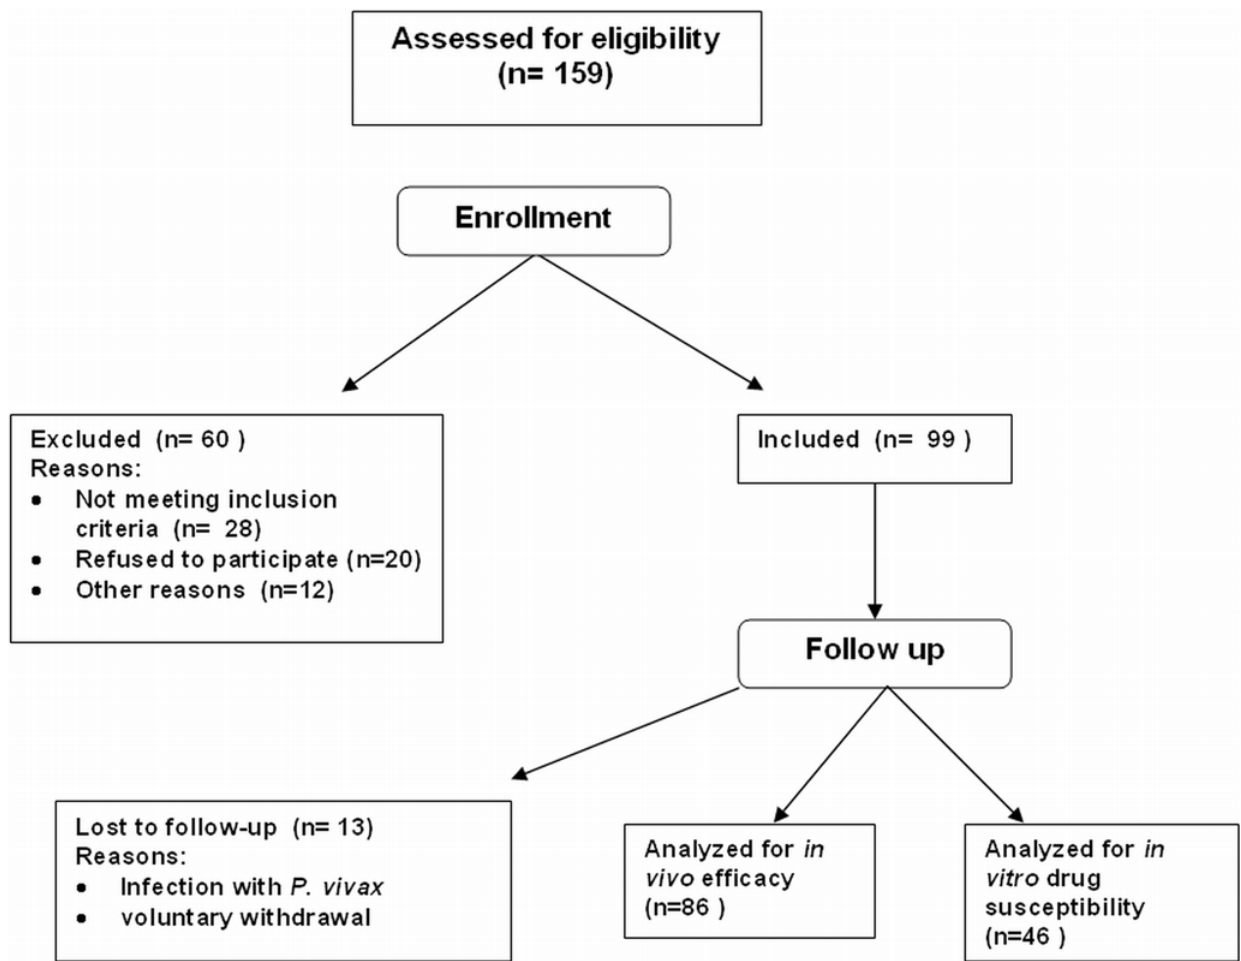
Figure 1. Flow chart of the enrollment process for the SP invivo efficacy trial.